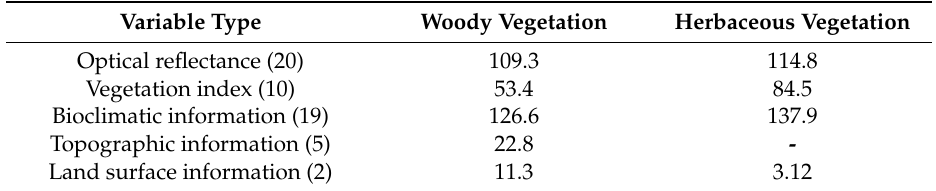
Table 3. The counts and summed scores of predictor variable importance for each data type. The types of variables with higher values are considered to be more important for